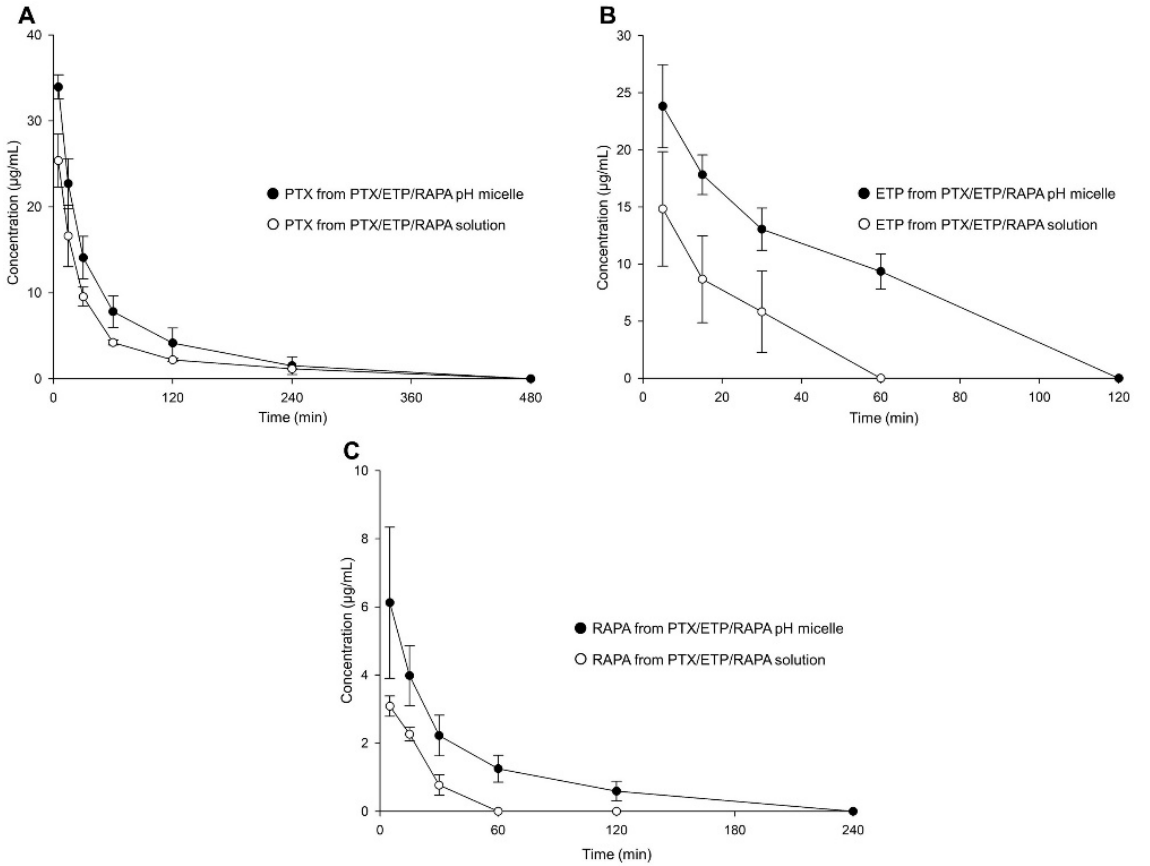
Figure 6. Plasma concentration–time profiles of PTX, ETP, and RAPA after intravenous injection. ( A ) PTX, ( B ) ETP, and ( C ) RAPA concentration in PTX/ETP/RAPA-loaded mPEG-pH-PCL micelles and PTX/ETP/RAPA solution (n = 3). Table 4. Pharmacokinetic parameters of paclitaxel (PTX), etoposide (ETP), and rapamycin (RAPA)